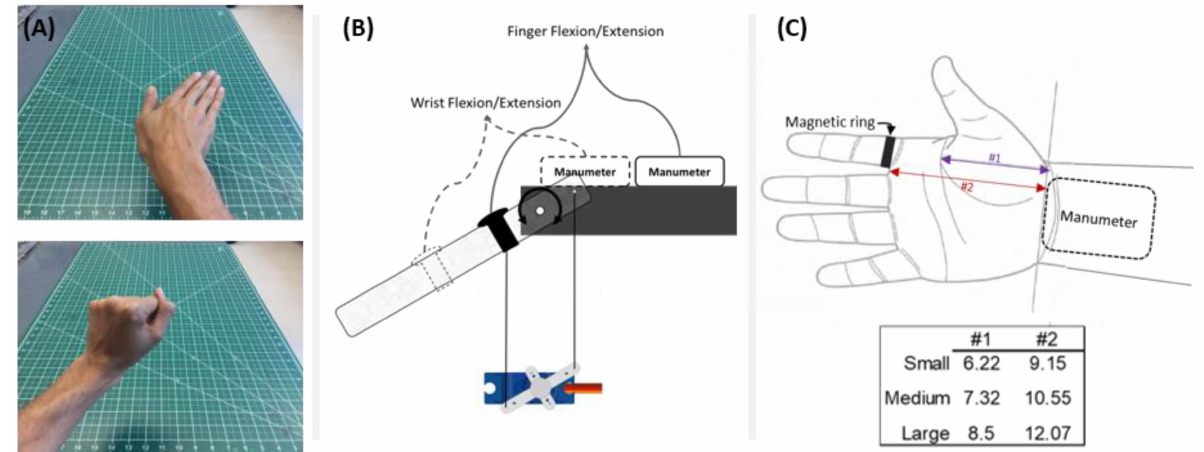
Figure 3. Overview of experimental methods used to produce known hand counts. ( A ): Screenshots of movie showing two of the desired hand postures that participants had to mimic during the hand-only exercises. ( B ) Apparatus used for movement emulation. For wrist flexion and extension, the wrist joint was emulated, and the acrylic piece represented the hand and index finger together. For finger flexion and extension, the metacarpo-phalangeal (MCP) joint of the index finger was emulated and the acrylic piece represented the index finger only. ( C ) Measurements used for defining the emulated hand sizes in centimeters. The Manumeter was aligned with the wrist crease baseline and the magnetic ring was placed touching the interdigital folds of the index and middle finger. Dimension #1 is from the wrist crease baseline to the intersection of the distal transverse palm crease with the ulnar edge of the palm. This is the best approximation to the center of rotation for the MCP joint of the index finger. Dimension #2 goes from wrist crease baseline (which closely aligns with the center of rotation of the wrist) and the interdigital folds of the index and middle